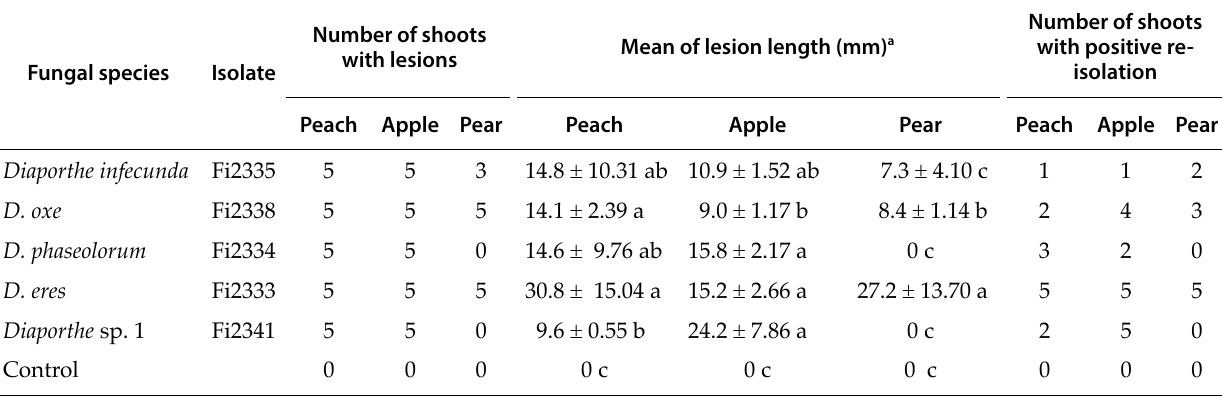
Table 3. Numbers of shoots with lesions after artificial inoculation of five Diaporthe spp. on detached shoots of peach, apple or pear trees, mean lesion length and numbers of shoots with positive re-isolation of inoculated isolates.